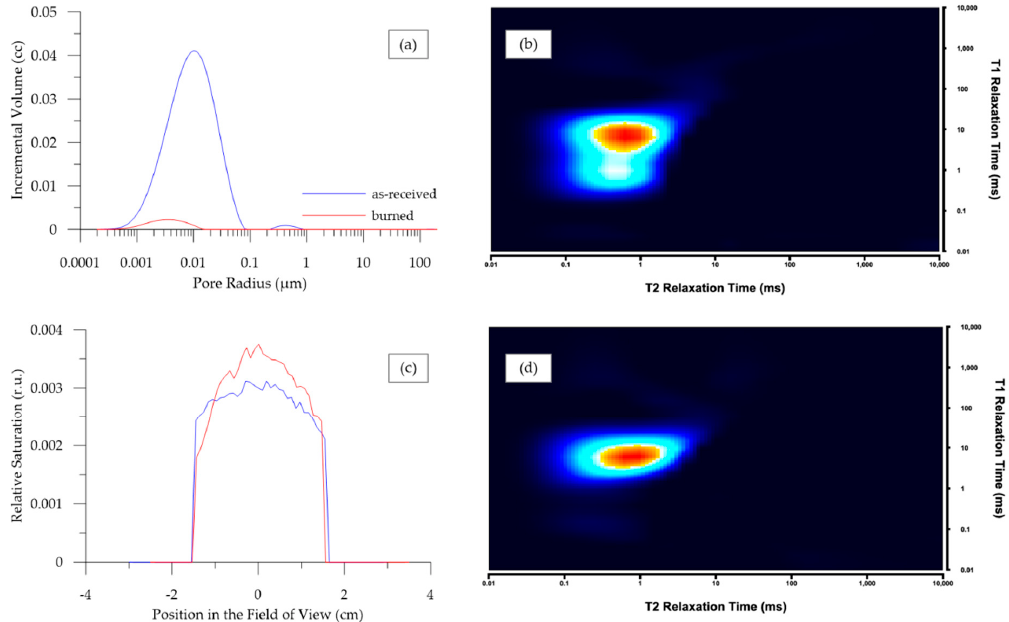
Figure 10. NMR analysis of sample #16: ( a ) T 2 relaxation before (blue) and after CT (red); ( b ) T 1 –T 2 map for as-received sample; ( c ) saturation profiles before (blue) and after CT (red); ( d ) T 1 –T 2 map for the burnt sample.